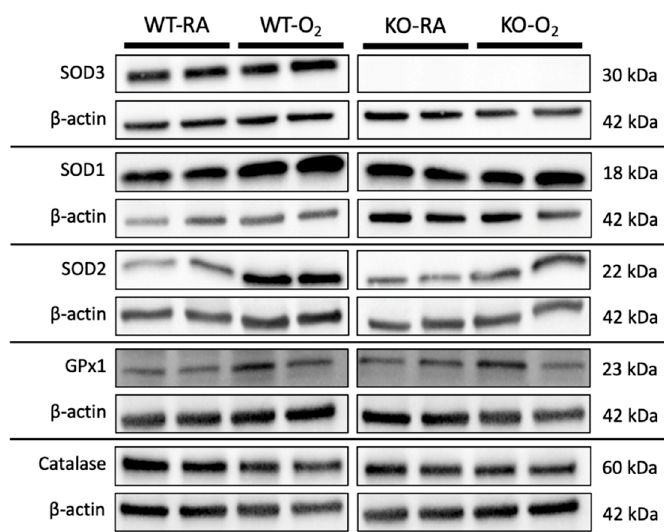
Figure 4. SOD3 protein was absent in KO mice, but other antioxidant enzyme expression was not affected by genotype. ( A ) Western blot analysis was used to evaluate lung protein expression of SOD3, SOD1, SOD2, GPX-1, and catalase in WT and KO mice exposed to either RA or O 2 for 14 days. Protein expression was normalized to β -actin. No SOD3 protein was detected in KO mice, and O 2 exposure did not affect SOD3 expression in WT mice. O 2 exposure was associated with increased SOD2 expression in both genotypes (as previously described [1]) and decreased catalase expression in WT mice. Data are presented as means ± SEM; * p <0.0001 vs. WT RA, ˆ p < 0.05 vs. WT RA, # p < 0.01 vs. KO RA, by two-way ANOVA with multiple comparisons; n = 4–6 per group. ( B ) Representative blot images are presented.